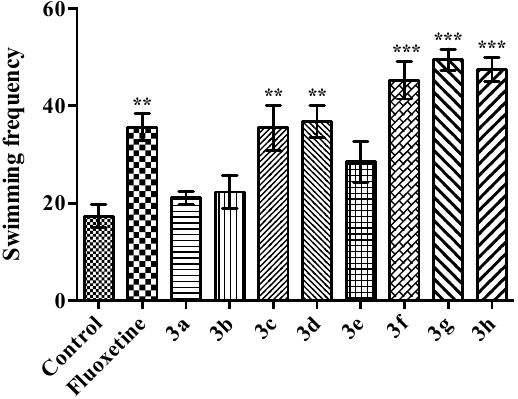
Figure 3. The effects of the test compounds 3a – 3h (40 mg/kg) and fluoxetine (20 mg/kg) on the swimming frequencies of the mice in MFST. Significant differences versus control values, ** p < 0.01, *** p < 0.001. Values are given as mean ± SEM, ( n = 6).